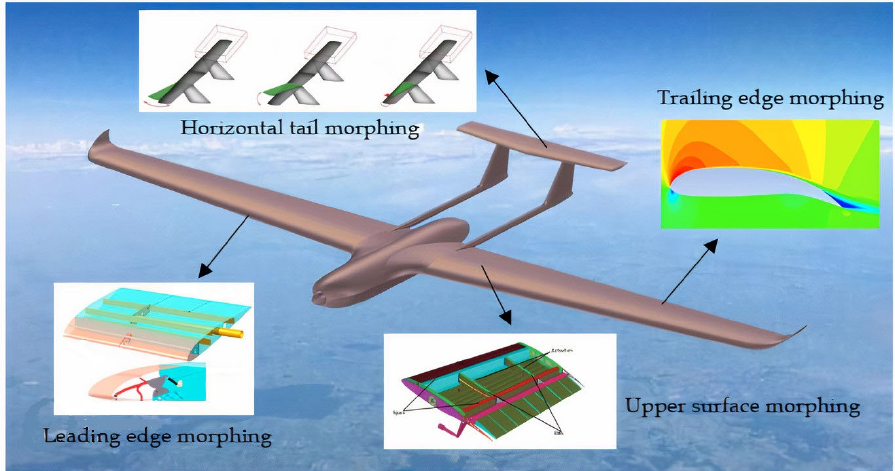
Figure 1. Morphing studies and optimizations conducted on the UAS ‐ S45 at LARCASE.